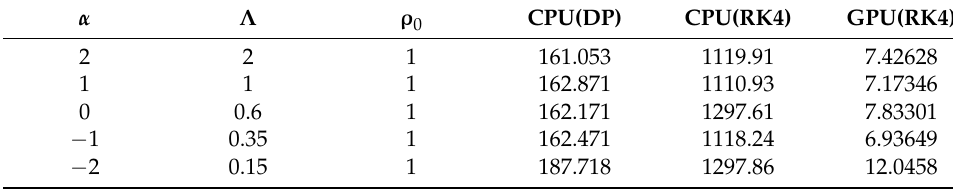
Table 2. LA surfaces of revolution and their average computation time (in